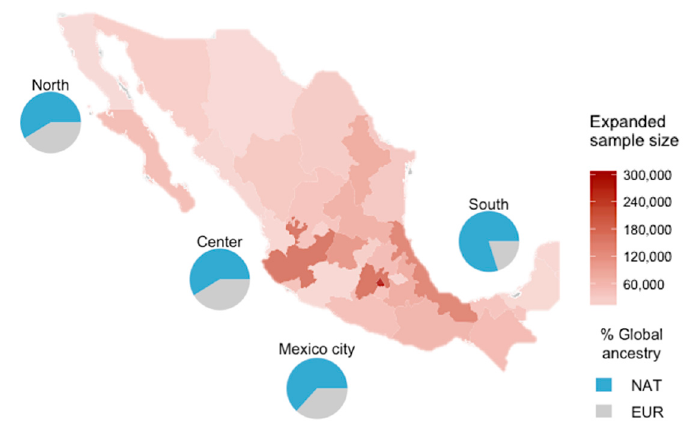
Figure 1. Sample size representation across states of Mexico. Pie plots show the global ancestry proportions for each of the four geographic regions of Mexico.